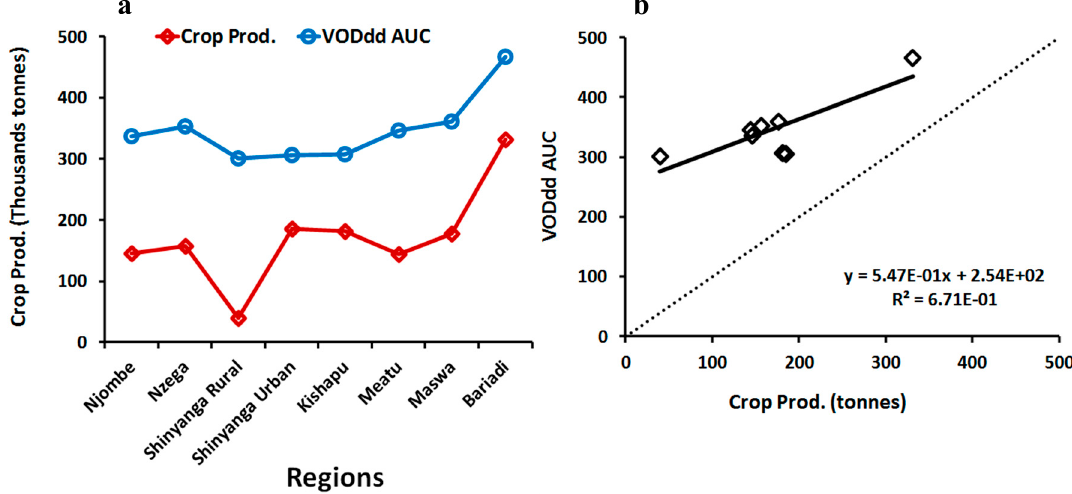
Figure 14. Graphs of ( a ) crop production statistical data and VODdd AUC and ( b ) their linear regression fit across regions in Tanzania for 2008. The fit was significant at p < 0.01.